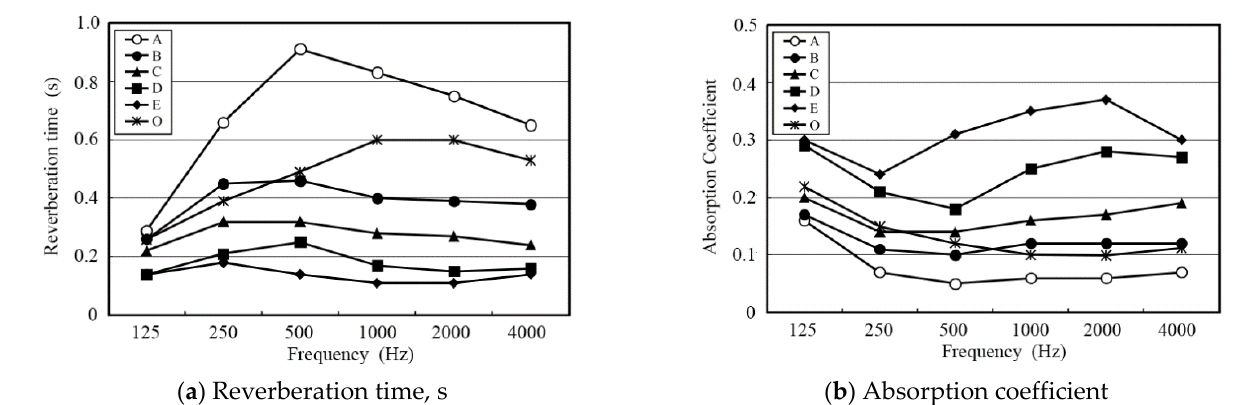
Figure 3. Results of the measurement in the front chamber (O) and five absorption patterns (A–E): ( a ) Reverberation time (s); ( b ) Absorption coefficient.